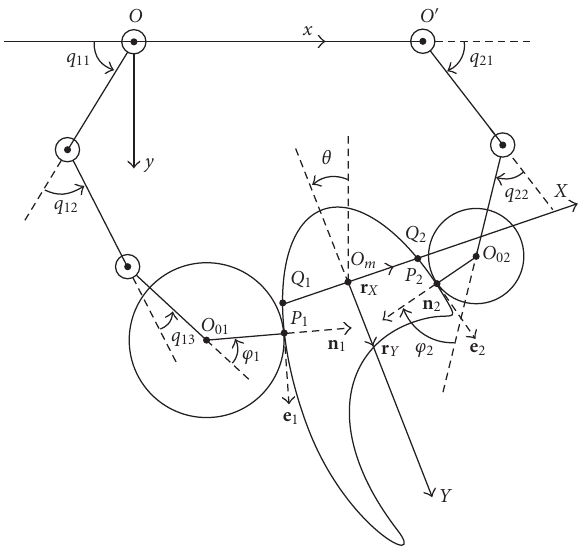
Figure 6: Two-dimensional object grasping by a pair of multijoint robot fingers.